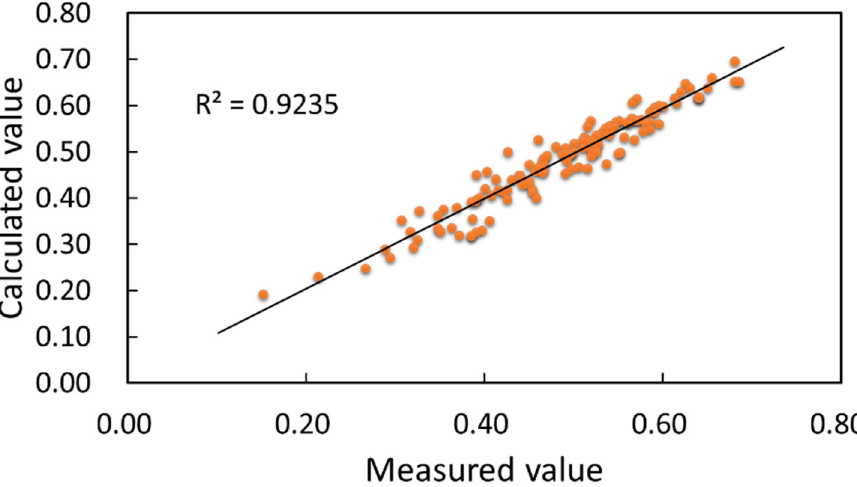
Figure 25. Linear relationship between calculated and measured values of canopy crown width.